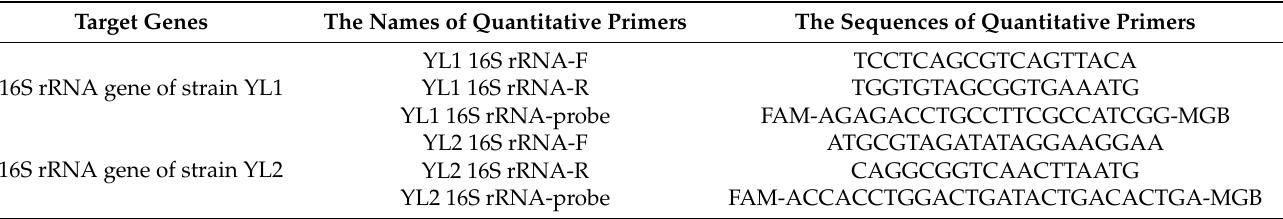
Table 1. The names and sequences of quantitative